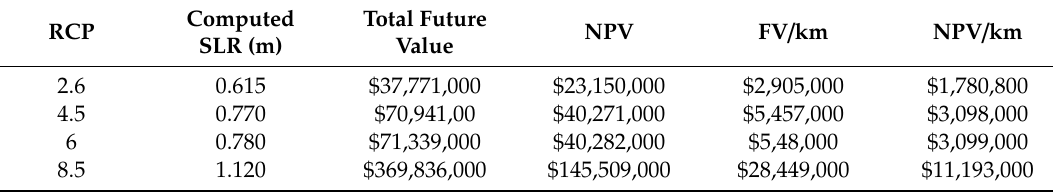
Table 7. Costs of coastal protection between 2020 and 2100 (2016 USD) (r = 1%; inflation = 1.7%). Computed RCP SLR